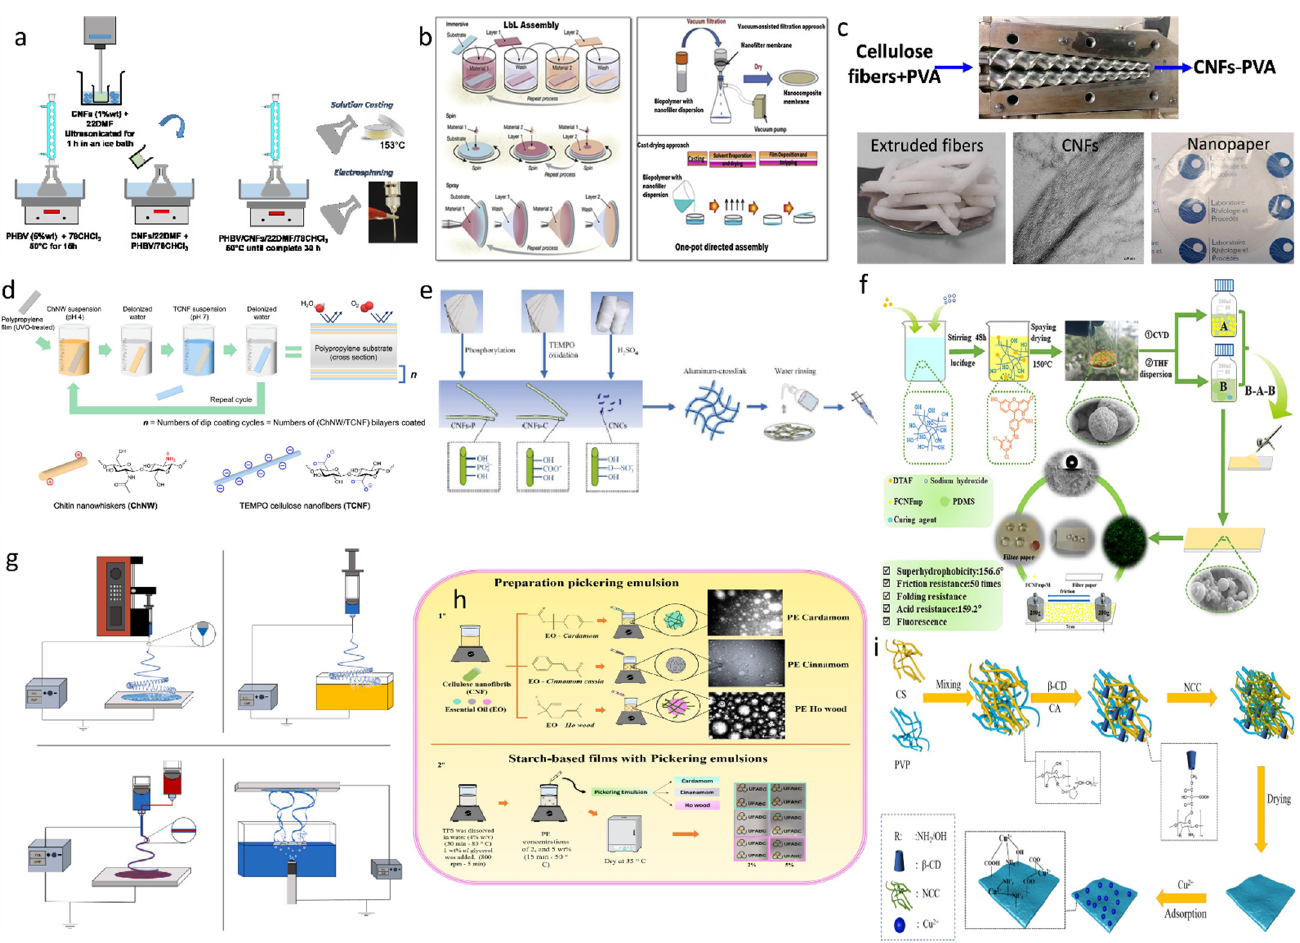
Figure 7. Fabrication strategies of nanocellulose ‐ based composites: ( a ) solution casting, reprinted